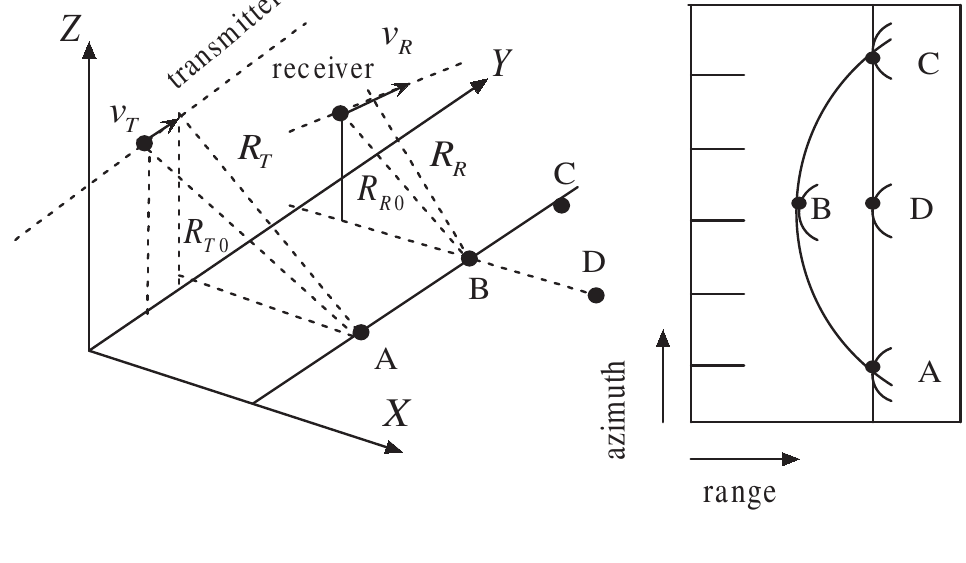
Figure 3. Targets with the same range delay at the zero-Doppler but will have different range